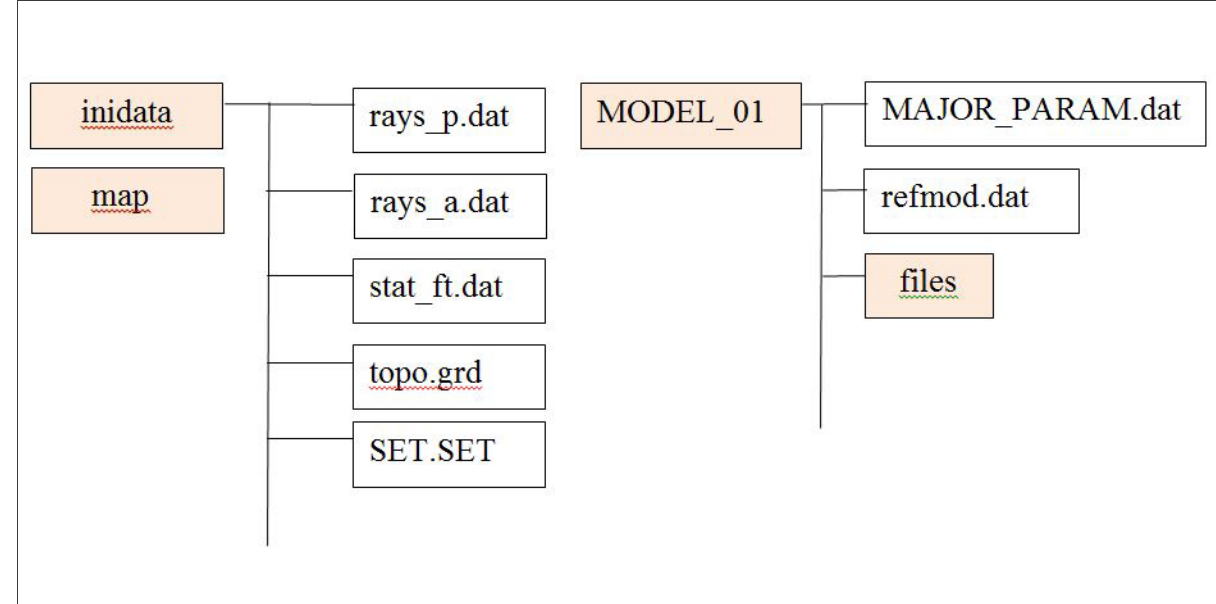
Figure A.3. Inidata and MODEL_01 directories scheme.